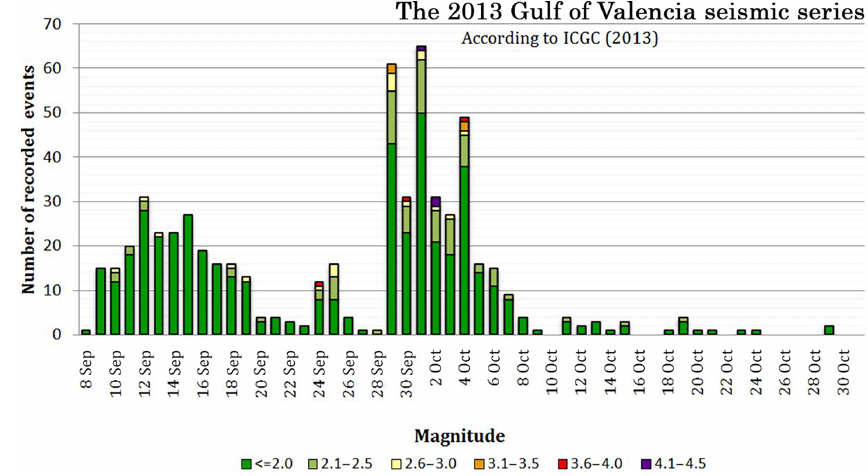
Figure 2. Histogram of Castor’s seismic sequence showing the number of earthquakes per day and their magnitudes. Two separate phases can be distinguished in this sequence. The first lasted until 19 September, just 2 days after injections were stopped, and maximum magnitudes did not surpass M 3. After 4 days of almost no seismicity, the first felt earthquake took place on 24 September ( M 3.7), and high levels of seismicity with three M 4 earthquakes were recorded during the 2 following weeks. Modified from ICGC (2013).